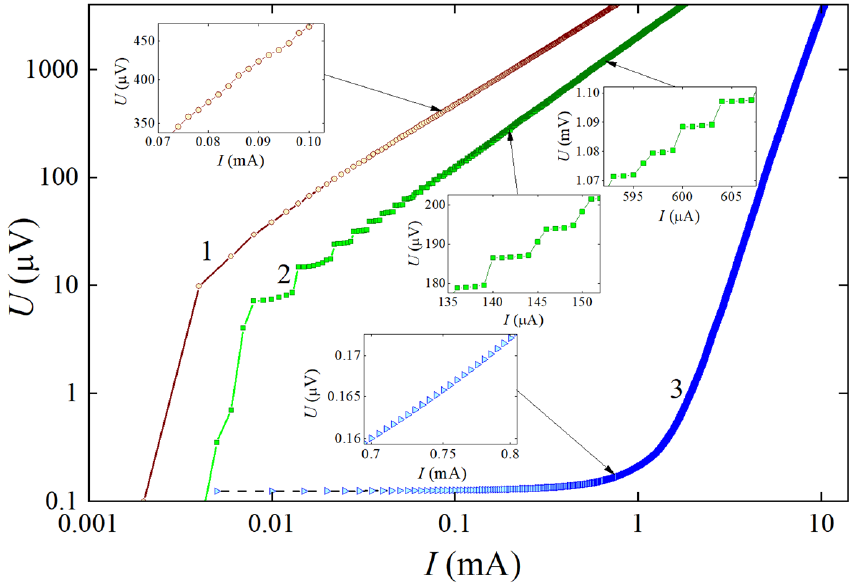
Figure 3. Log-log plot of the current–voltage ( I–V ) characteristics of sample 1 (curve 1), sample 2 (curve 2) and the reference sample (curve 3) measured at fixed temperature T = 87.74 K = 0.96 · T c . The insets represent the fragments of the V characteristics on the expanded linear